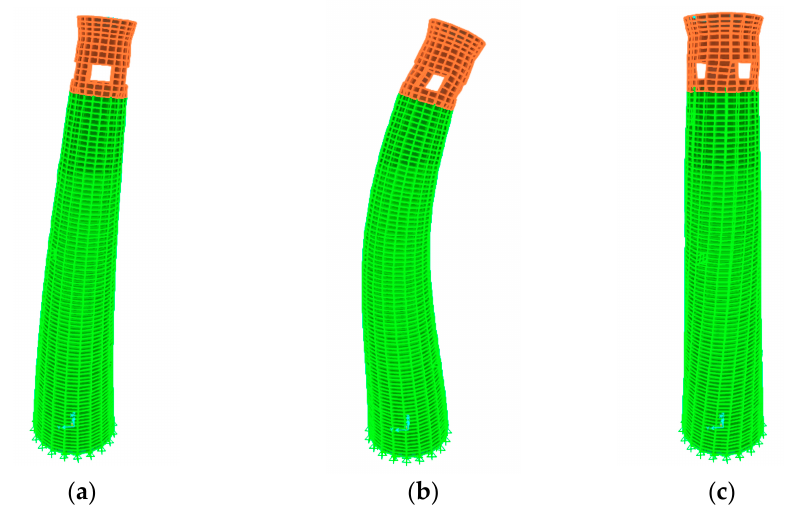
Figure 19. Minaret’s first three modes of vibration: ( a ) first mode in NS and EW directions ( F 1 and F 2 ); ( b ) second mode in NS and EW directions ( F 3 and F 4 ); ( c ) torsional mode ( F 5 ).